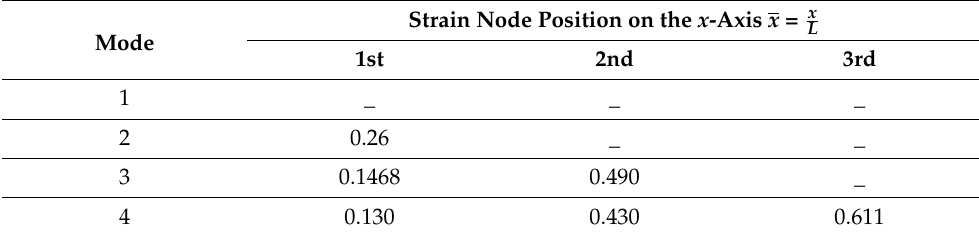
Table 2. Strain mode position of a trapezoidal cantilever beam with tip